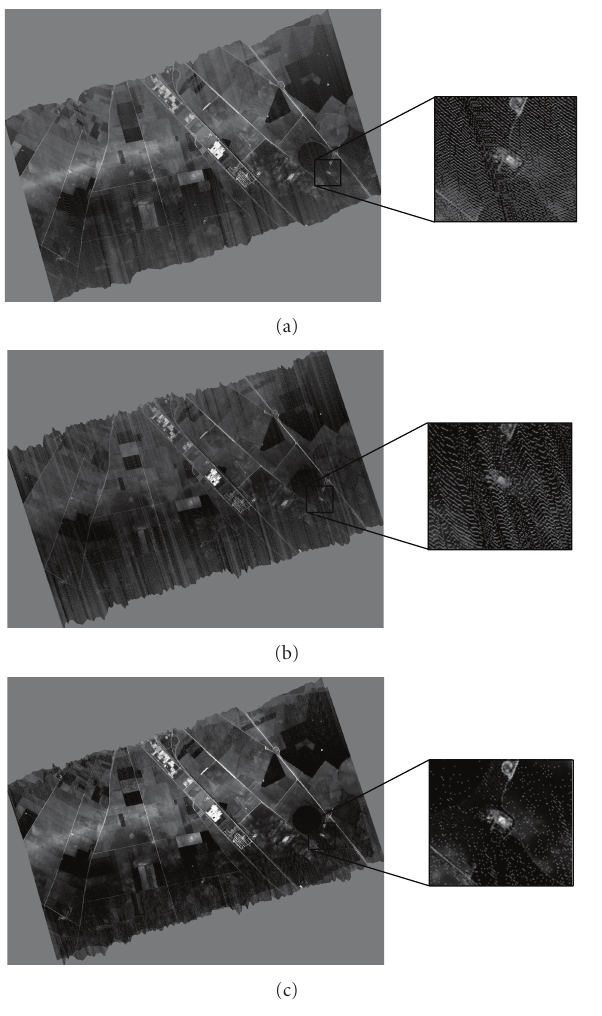
Figure 4: DMF versions of the Barrax dataset: (a) data acquired from the first overpass; (b) data acquired from the second overpass; (c) DMF structure storing all the measurements by both times- tamps.